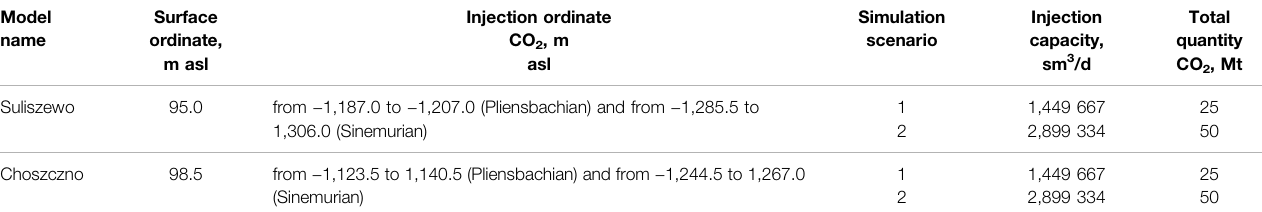
TABLE 4 | Summary of injection rates for different simulation variants.